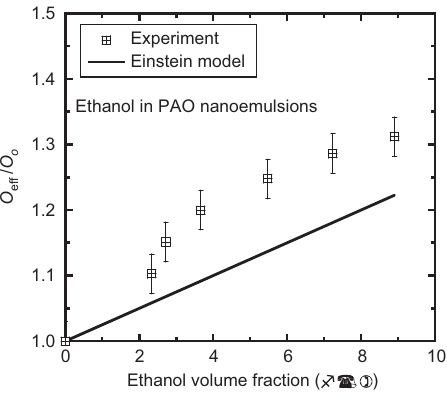
Figure 5 The relative viscosities of the ethanol-in-PAO nanoemul- sions measured at the different volumetric fractions of the ethanol nanodroplets. The measurements were conducted at room tempera- ture using a Brookfield viscometer.